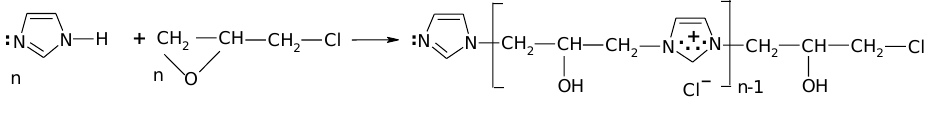
Figure 1. Proposed reaction of the synthesis [IME] + Cl − . Commercial-grade quality [IME] + Cl − used for the cationisation of cellulose was analysed for its nitrogen content, cationicity and reactivity values, copolymerisation degree and macromolecular weight.